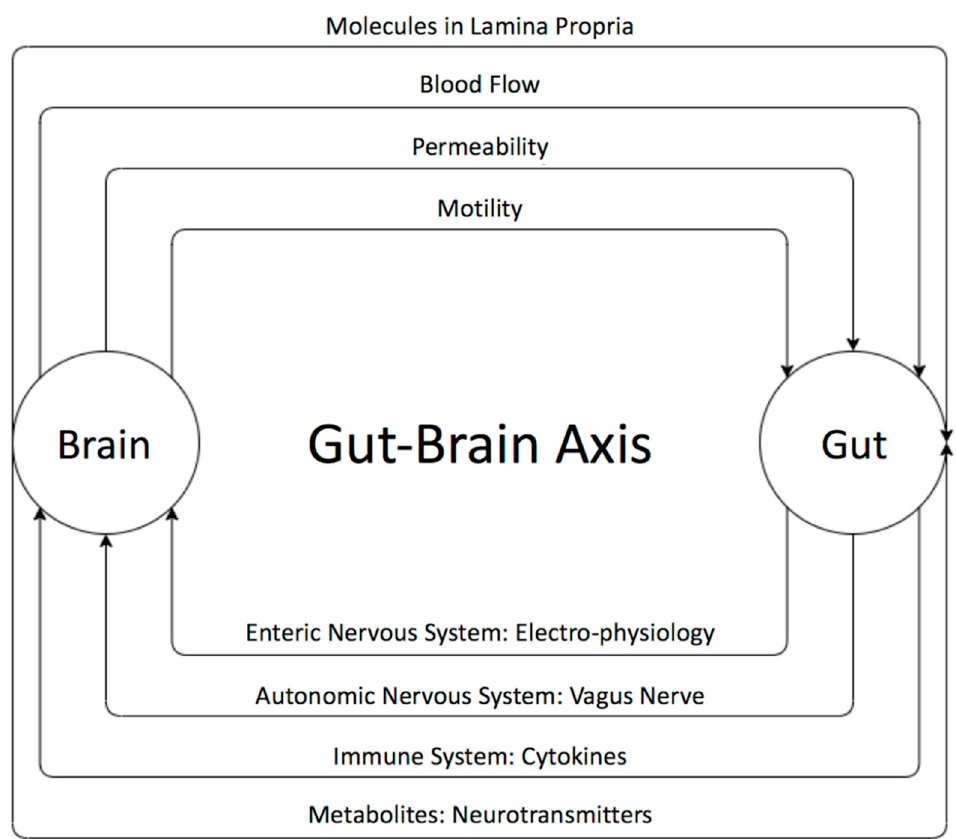
Figure 1. The bi-directional relationship between the gut and the brain and its players. The brain can influence the gut microbiota through changes in gastrointestinal motility, intestinal permeability, blood flow, and the release of molecules in the lamina propria. The gut microbiota, in turn, influences the brain neural as well as immune system’s communication and active metabolites. The gut microbiota affects the brain through the enteric nervous system (ENS), which communicates with the autonomic and central nervous systems.